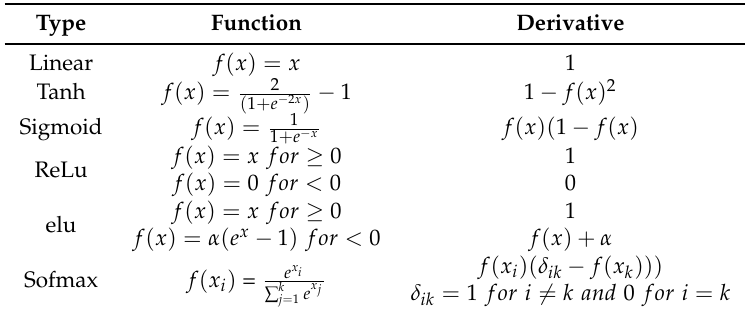
Table 2. List of activation